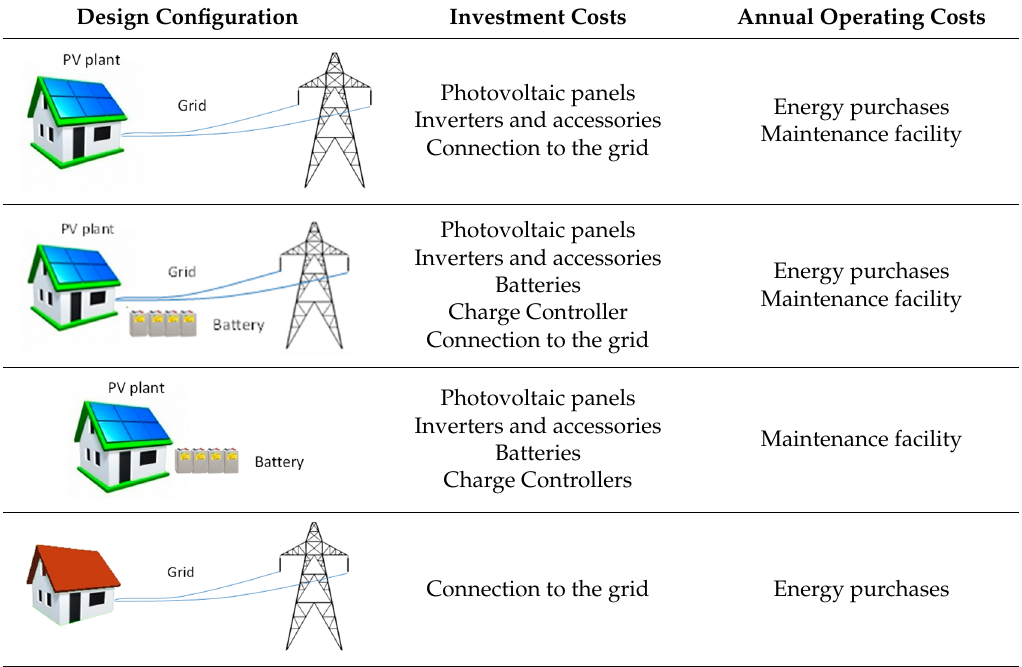
Table 1. Investment and operating costs.